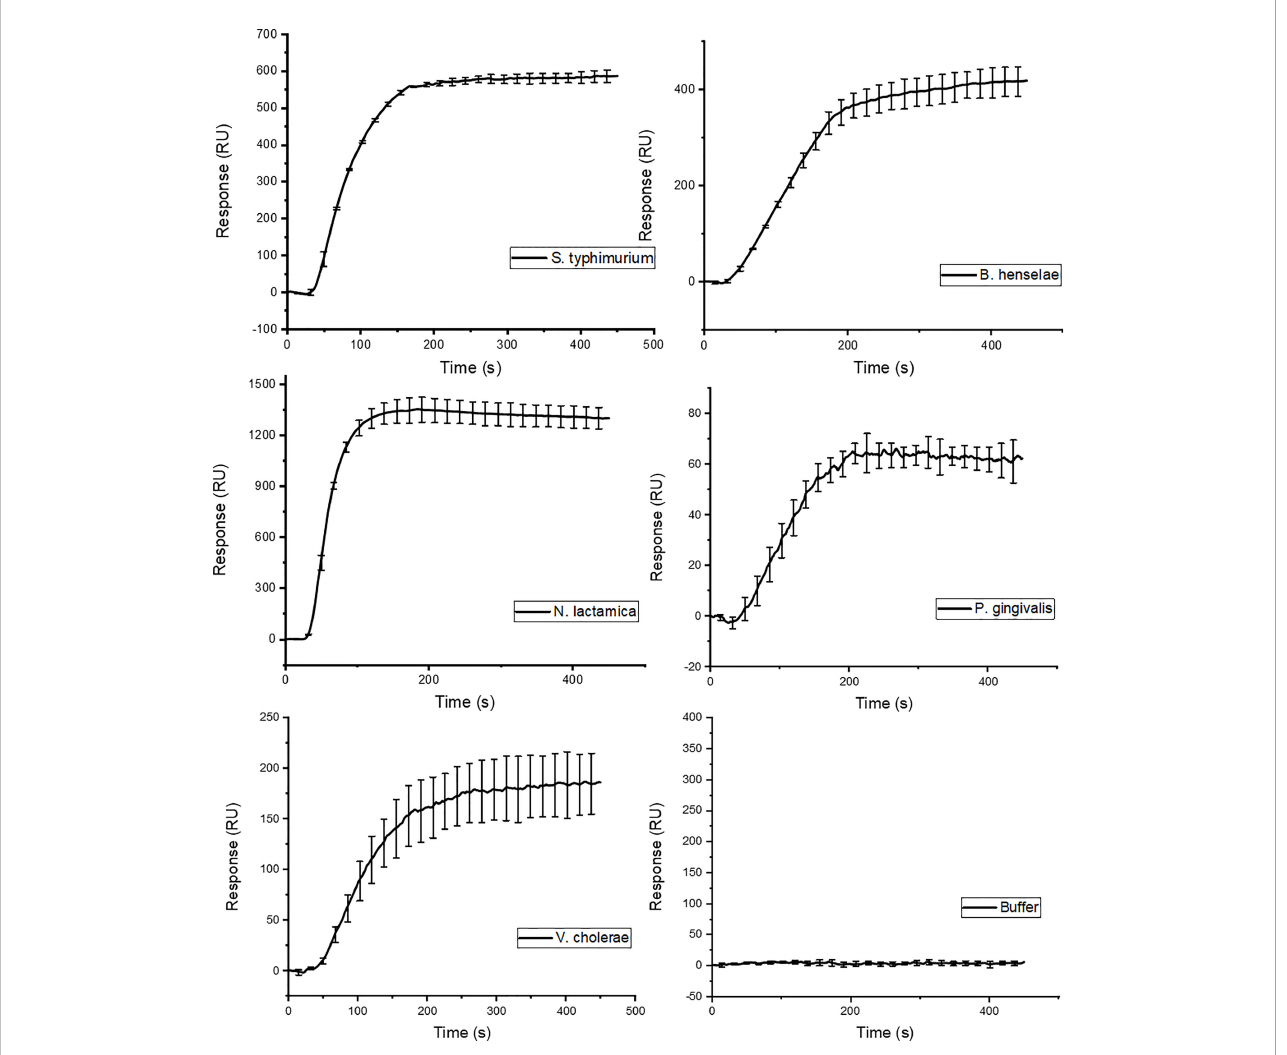
FIGURE 4 SPR binding isotherm following injection of LPS isolated from different Gram-negative species. The binding curves show the same binding characteristics as the ones observed for the S. typhimurium variants in Figure